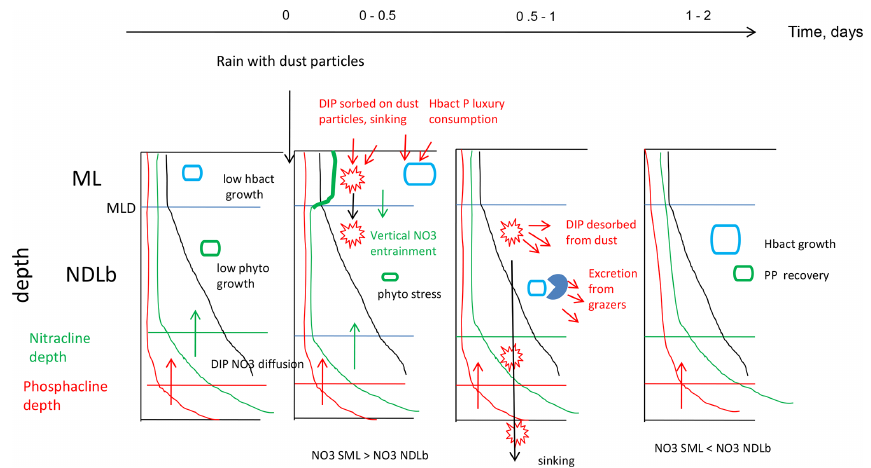
Figure 6. Synthetic view of biogeochemical processes and exchanges between the ML and NDLb at FAST before the rain and evolution after the